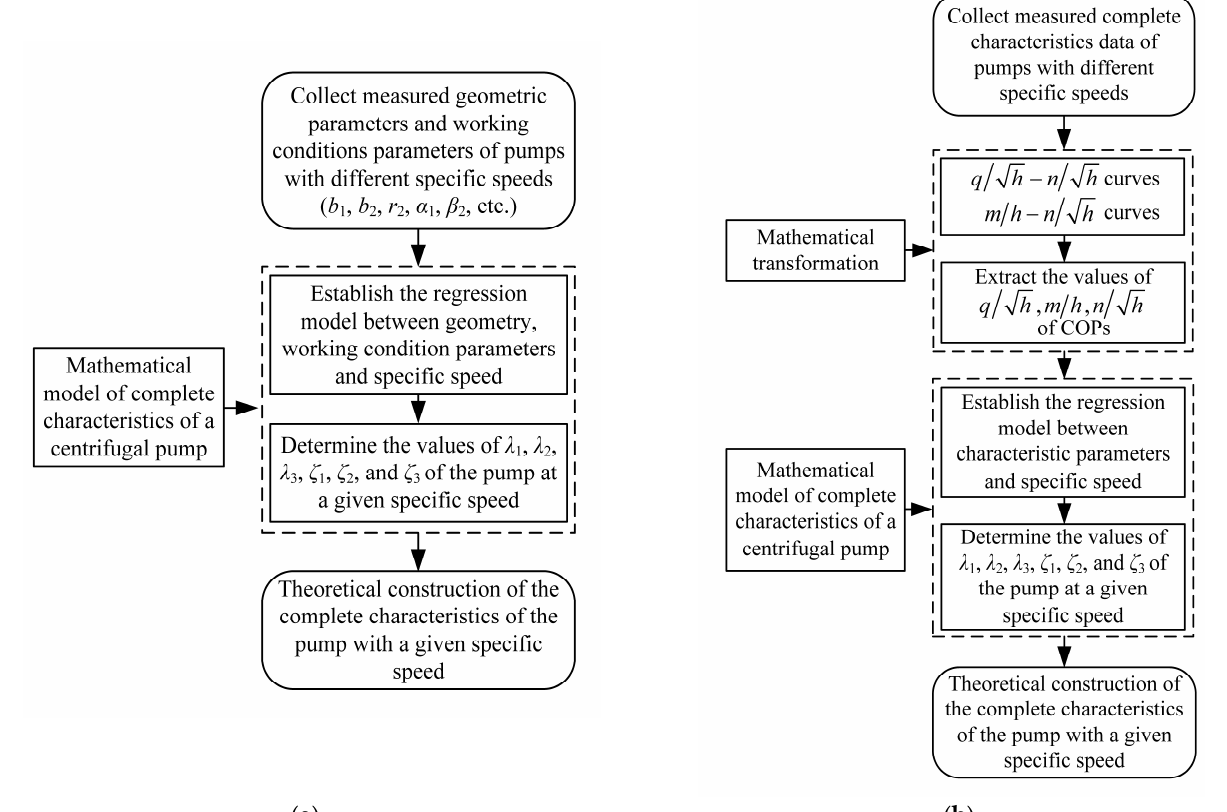
Figure 2. Flow charts of two methods: ( a ) direct method; ( b ) indirect method.